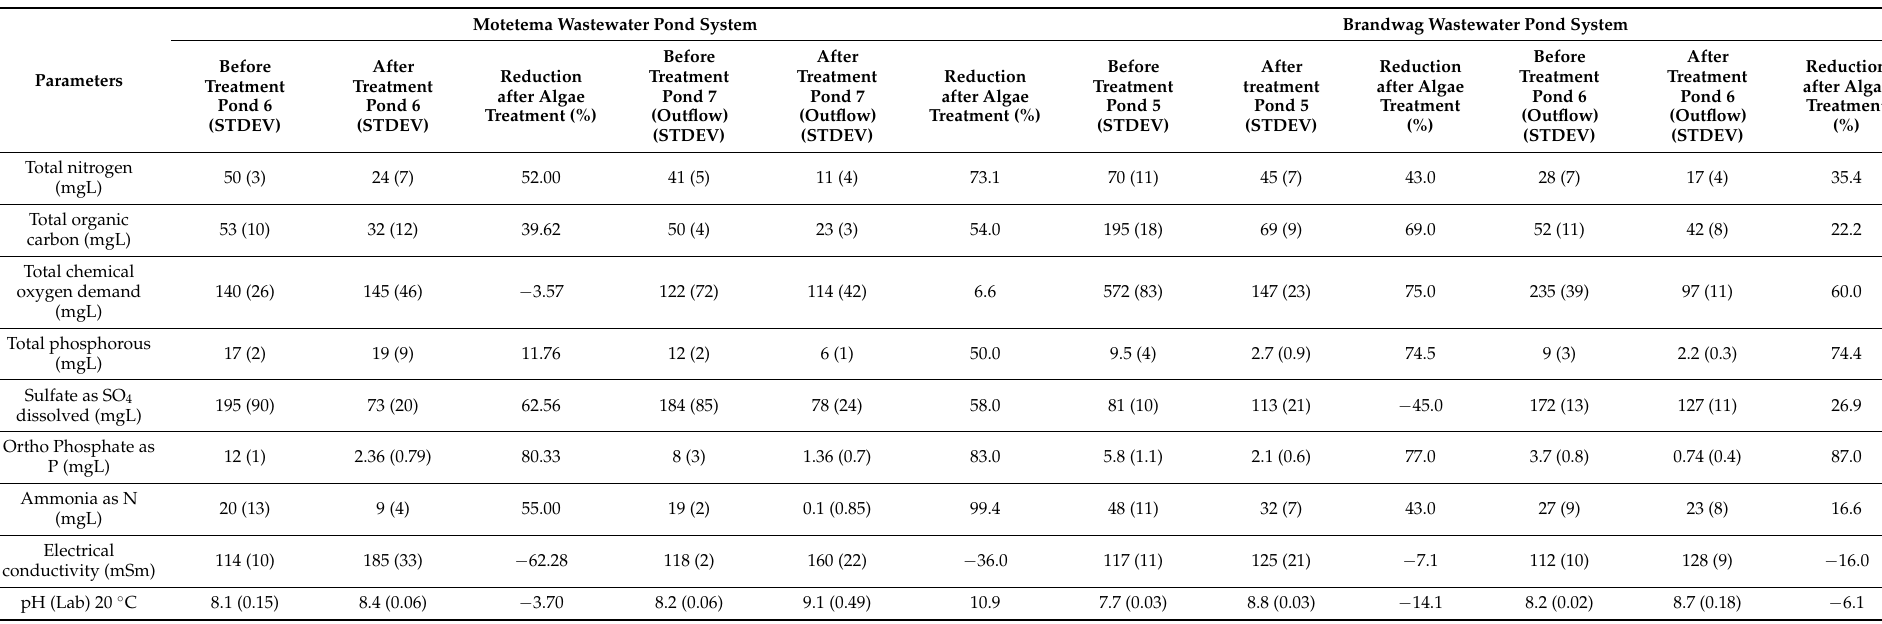
Table 2. Median of physical and chemical parameters measured before (day 0) and after treatment (one year later) with a specific consortium of microalgae at the Motetema (MT) wastewater pond system and Brandwag wastewater pond